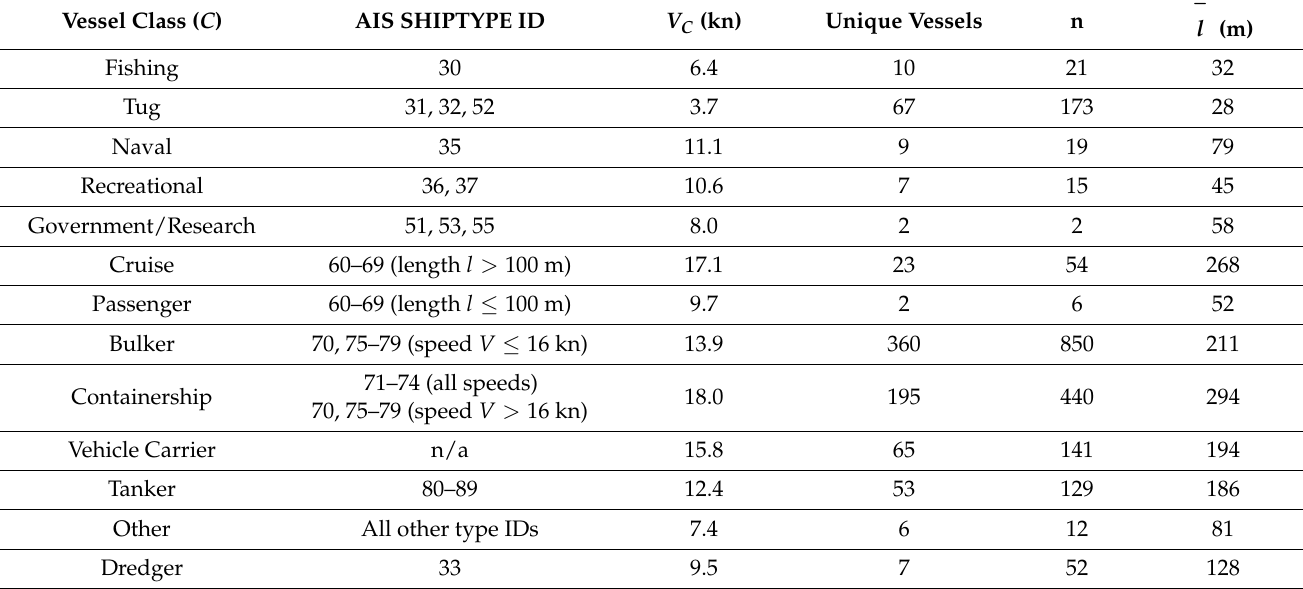
Table 1. The vessel class ( C ) is obtained from the AIS ‘ship type’ parameter, according to the following table, which also presents the reference speed ( V C ) per vessel class, the number of unique vessels, the number of measurements (n), and the mean length ( l ) per vessel type of the measured ships in the ECHO data set and the dredgers from [22] used for the present model development. Many vessels in the data set were measured more than